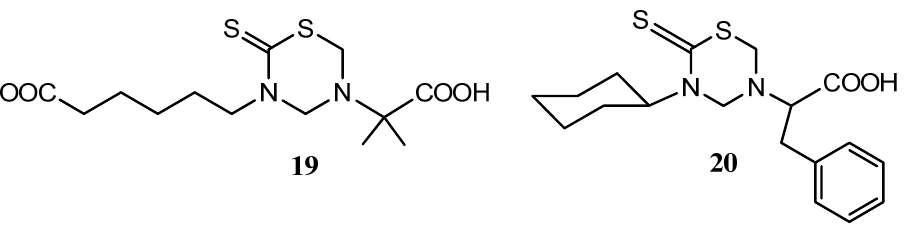
Figure 5. THTT derivatives with anti-amastigote